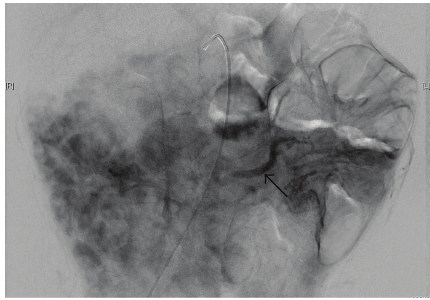
Figure 5: Angiogram showing prominent parenchymal contrast blush of the SMA vascular distribution, and prominent opacifica- tion of mesenteric veins (arrow).